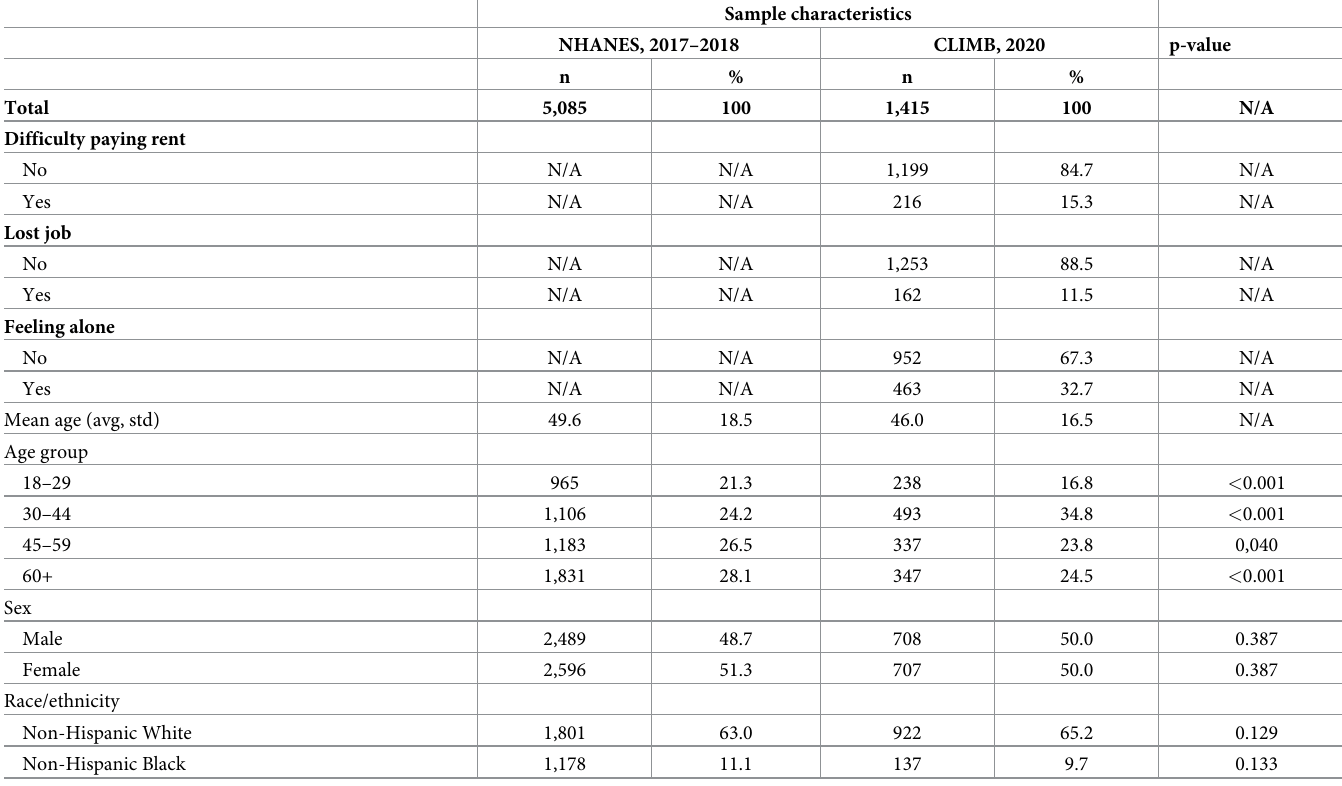
Table 1. Participant demographic